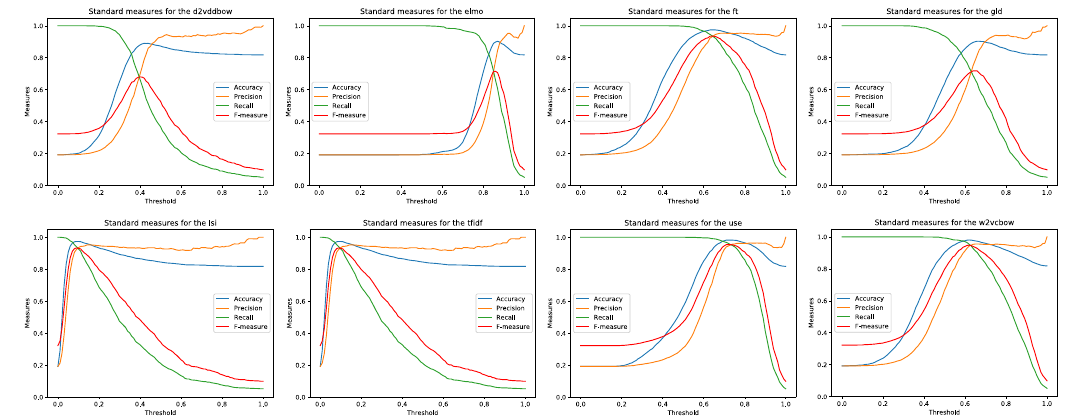
Figure 5. Standard evaluation measures for eight models processing C&S corpus.